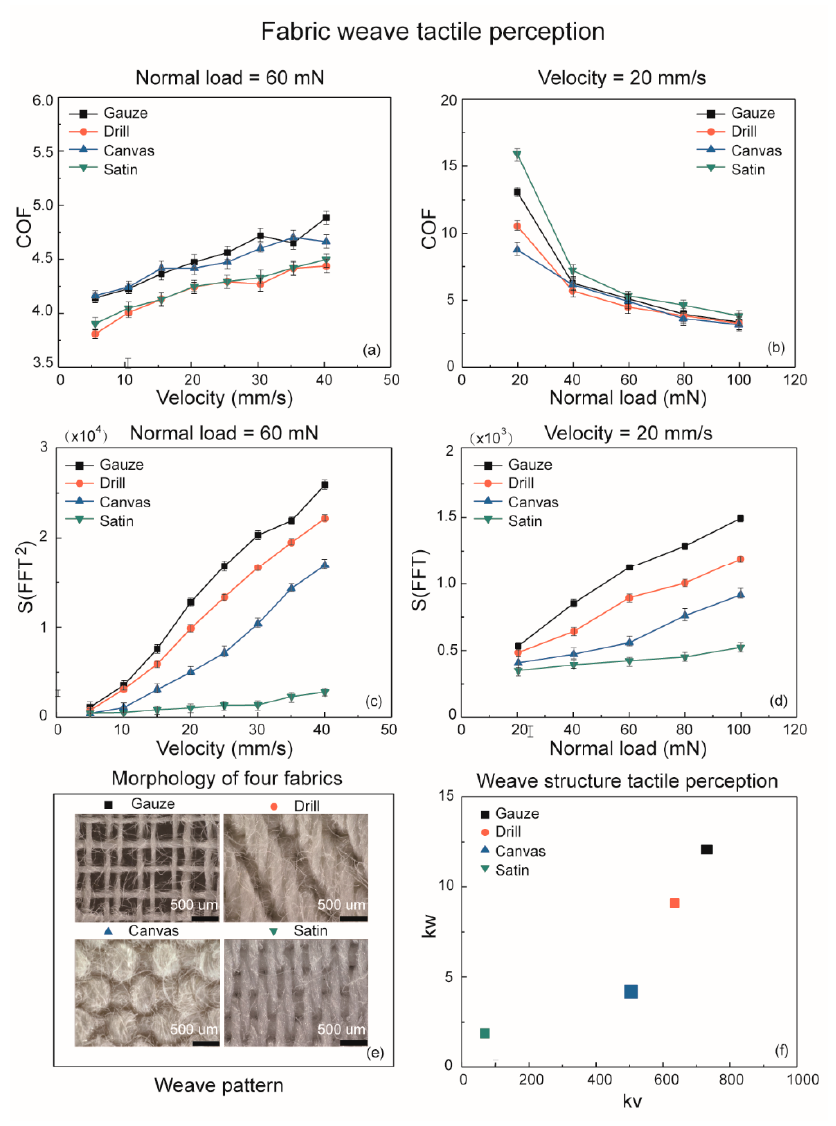
Figure 5. Frictional properties and tactile perception of four fabric weave patterns as a function of velocity and normal load on cotton fabrics. ( a ) Effect of velocity on friction coefficient at 60 mN preload. ( b ) Effect of normal load on friction coefficient at 20 mm/s scanning velocity. ( c ) Roughness tactile perception of four weave patterns by S ( FFT 2 ) at 60 mN normal load. ( d ) Hardness tactile perception of weave patterns by S ( FFT ) at 20 mm/s scanning velocity. ( e ) Microscope photographs of four cotton canvas fabrics with different weaves. ( f ) Fabric weave pattern tactile discrimination by kv and kw .